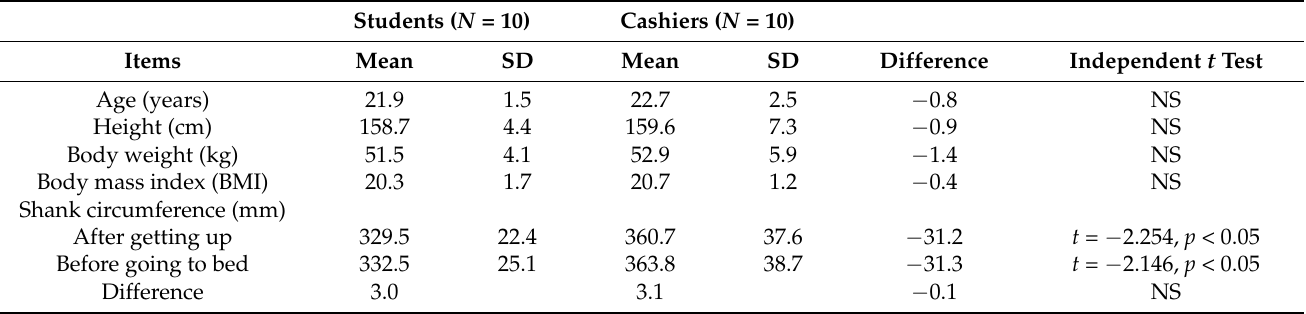
Table 1. Anthropometric data of the student and cashier participants.